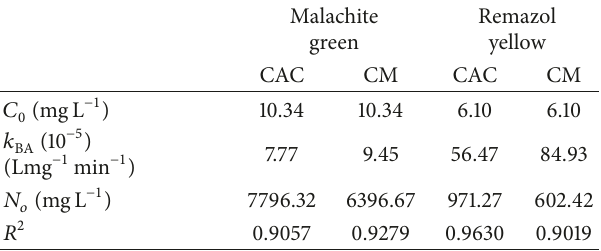
Table 3: Bohart-Adams–fitting parameters for the adsorption of malachite green and Remazol yellow using commercial activated carbon and carbonaceous